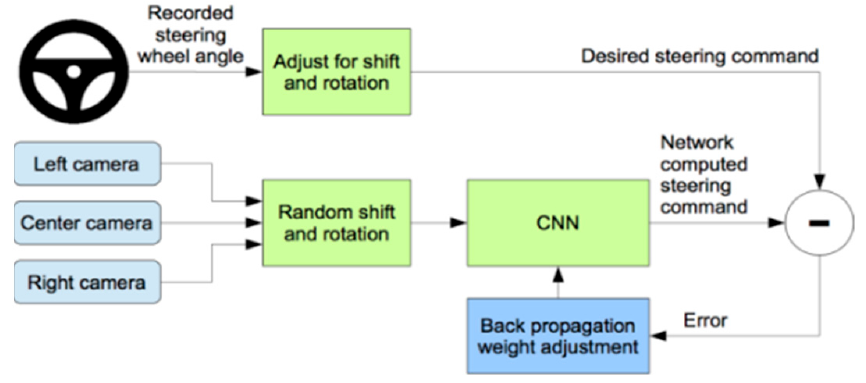
Figure 4. Training the neural network [13].